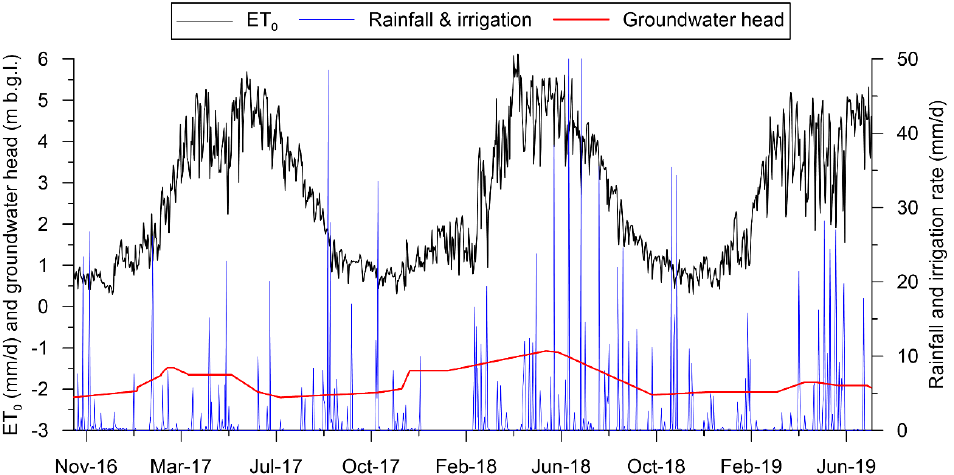
Figure 2. Rainfall and irrigation events (blue line), groundwater head (red line), and reference evapotranspiration (black line) observed at the field site.